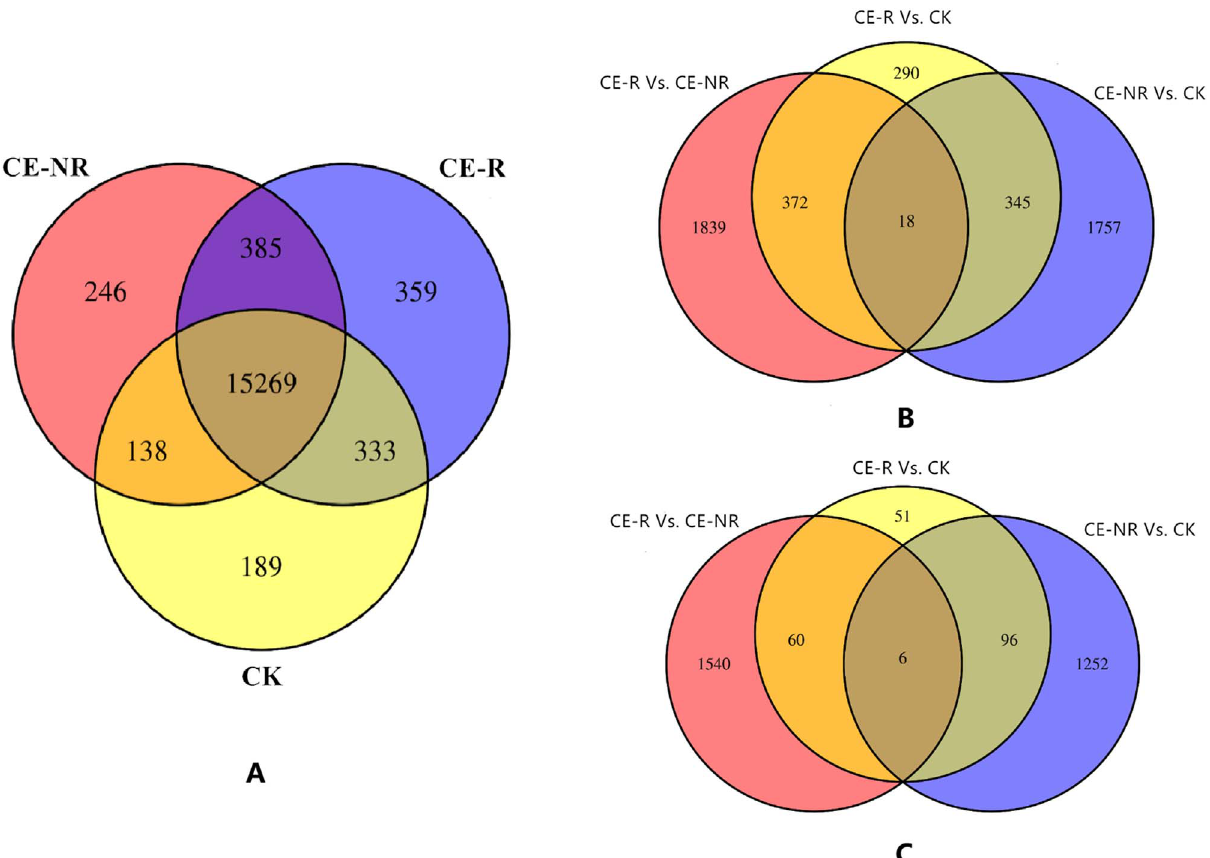
Figure 1. Venn diagram of all genes and differential expression genes (DEGs) between groups. Figure 1A shows all identi fi ed genes in each group. Figure 1B shows the upregulated DEGs between groups, while Figure 1C shows the downregulated DEGs between groups.